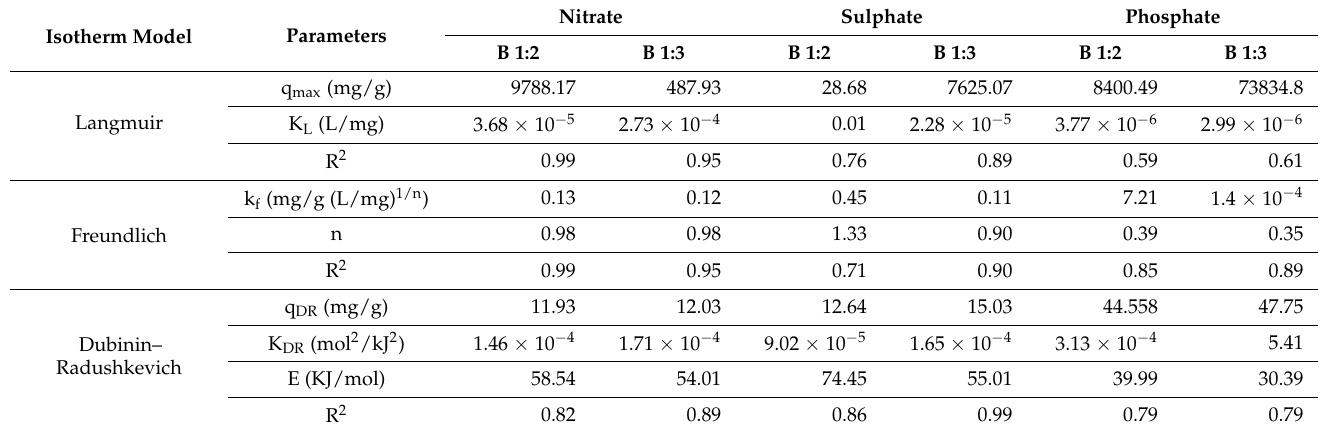
Table 2. Modelling adjustment parameters of the Cr (VI) adsorption